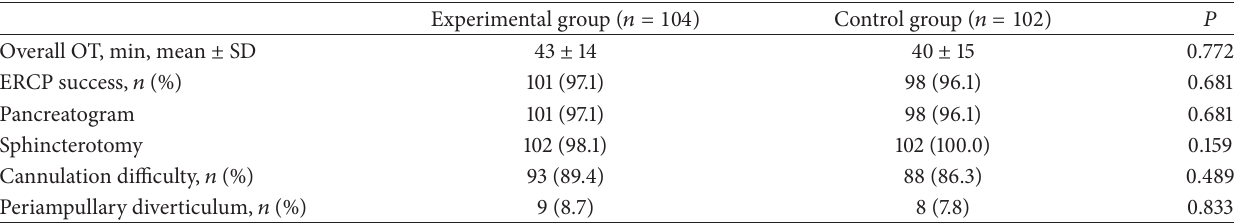
Table 2: Operative data of ERCP.